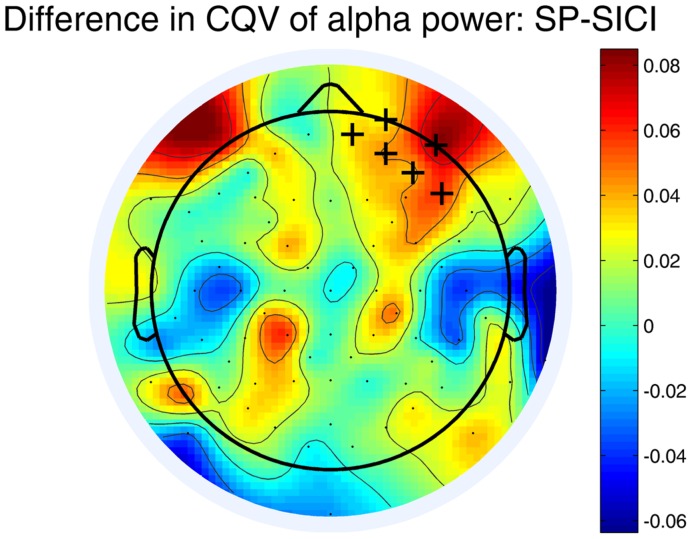
Differences in CQV of the alpha-power (10–12 Hz) between SP and SICI conditions. Crosses indicate the channels belonging to a significant cluster (P < 0.05) where CQV of alpha power in SP condition is higher. A color shows the difference between the CQVs (SP-SICI).